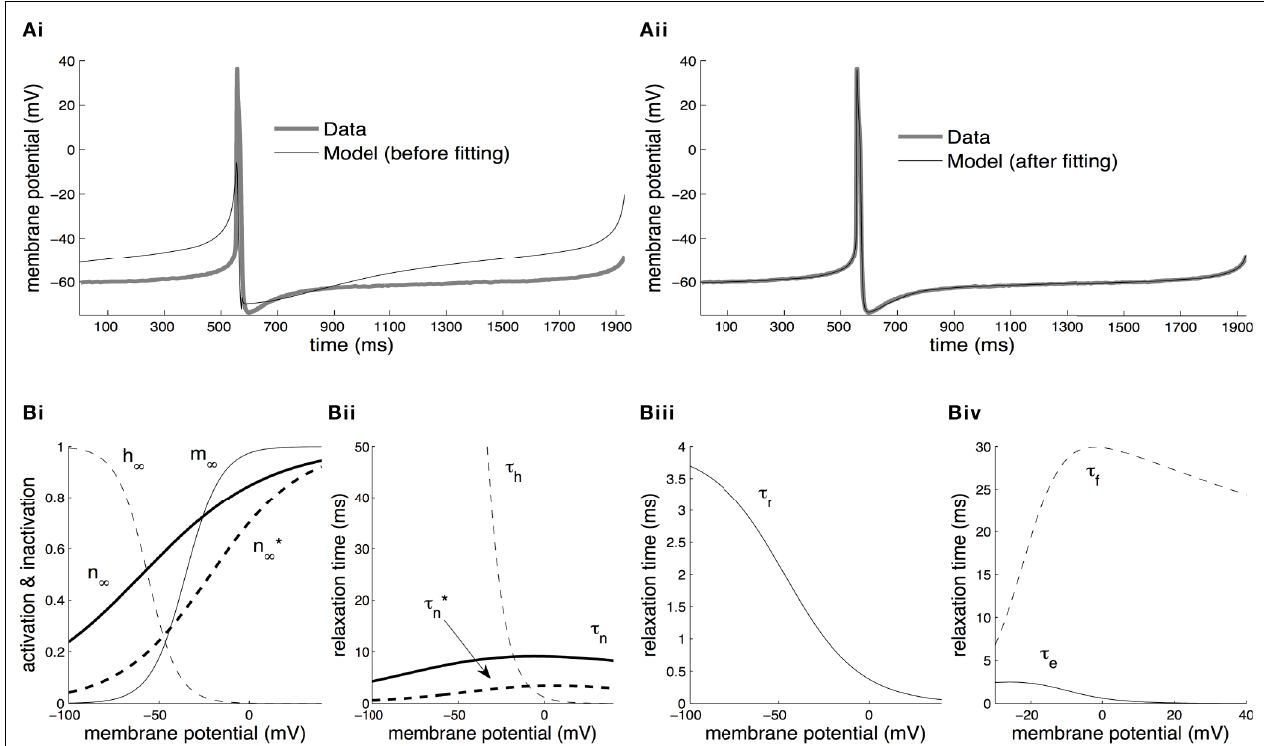
FIGURE 2 | Parameter estimation from current-clamp data. (A) The whole- cell model was fi tted against a two-electrode current-clamp recording of duration ∼ 1.9 s from CGCs in the intact nervous system of unconditioned animals. The parameters estimated at the previous stage from voltage-clamp data were kept fi xed, with the exception of those referring to the activation kinetics of the delayed rectifi er, I . During the optimization process, the free D parameters in the model progressively attained optimal values, as indicated by the gradual convergence of the model to the data (Ai, ii) . (B) The steady-state activation, m ∞ , and inactivation, h ∞ , of the transient sodium current were derived